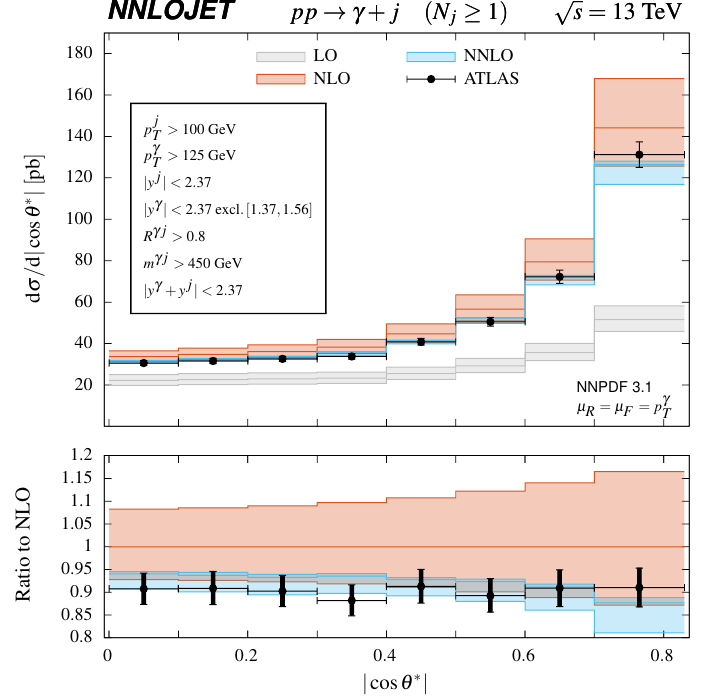
Figure 15 . Distribution in ATLAS data